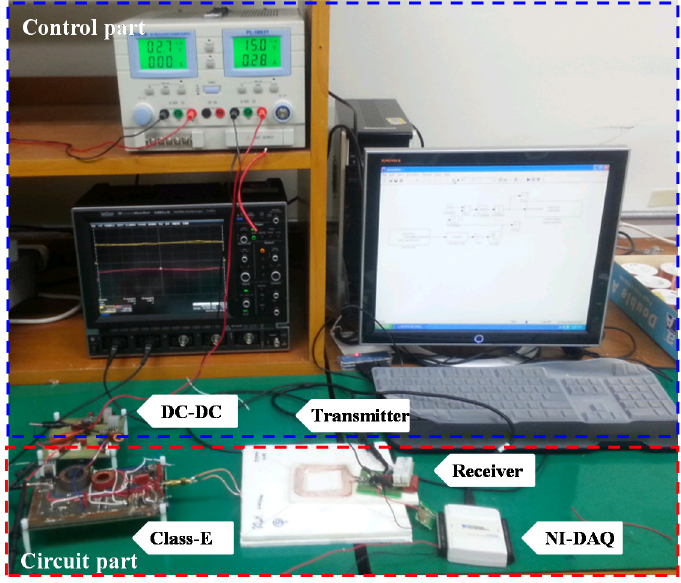
Figure 6. Experimental setup of software-based wireless power transfer